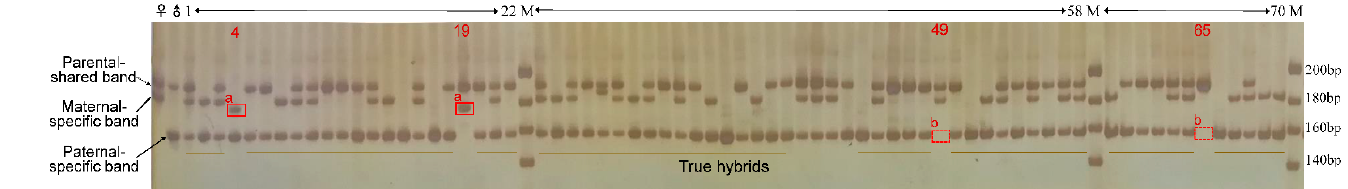
Table 2. Identification of true hybrids and foreign origins of 1122 F 1 individuals using five SSR markers